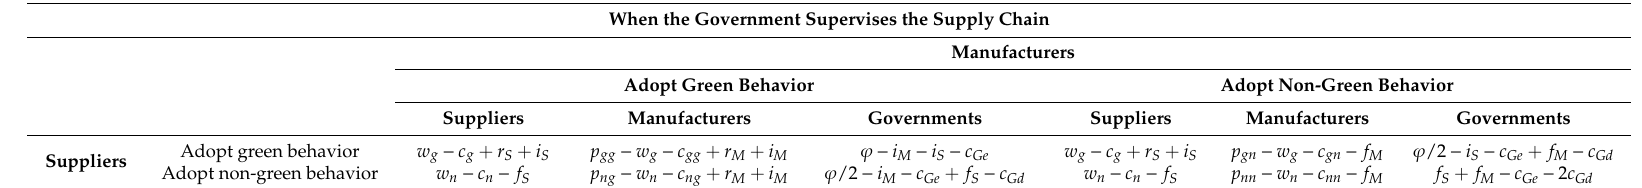
Table 3. Payo ff matrix with government